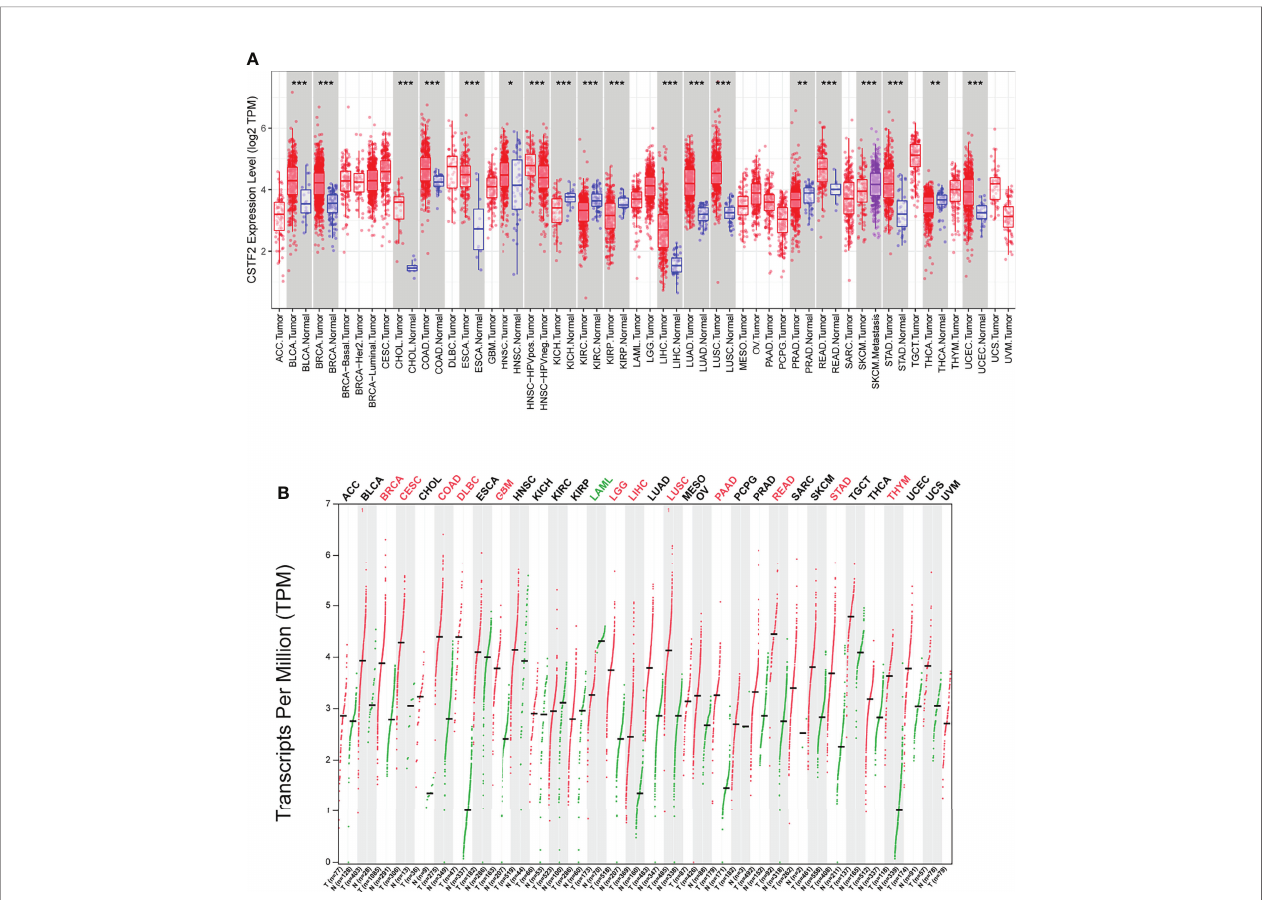
FIGURE 1 | The expression levels of CSTF2 in human cancers. (A) The expression levels of CSTF2 in different tumor tissues compared to normal tissues in The Cancer Genome Atlas (TCGA) database. (B) The expression of CSTF2 in tumor tissues and matched TCGA normal in TCGA database and GTEx data by GEPIA analysis. * r < 0.05, ** r < 0.01, *** r < 0.001 compared to normal